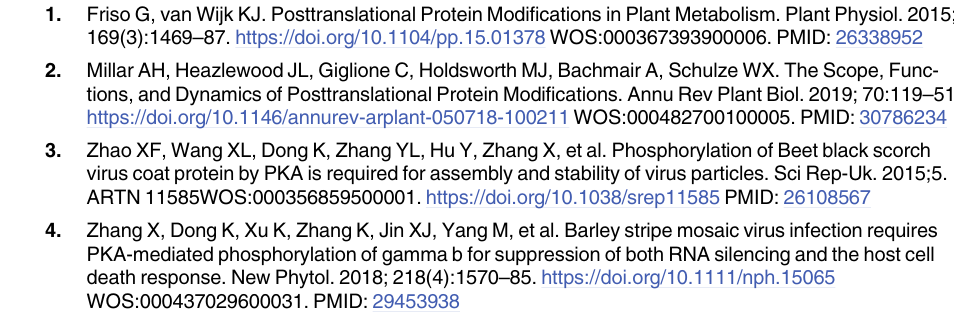
S10 Fig. Symptoms are classified based on the degree of yellowing and curling of the leaves infected with CWMV. S1 Table. The complete phospho-peptide sequences from the mass spectrum assay. S2 Table. The total of 15 positive clones obtained from the Y2H screening with the viral CRP as bait. S3 Table. Primers used in this